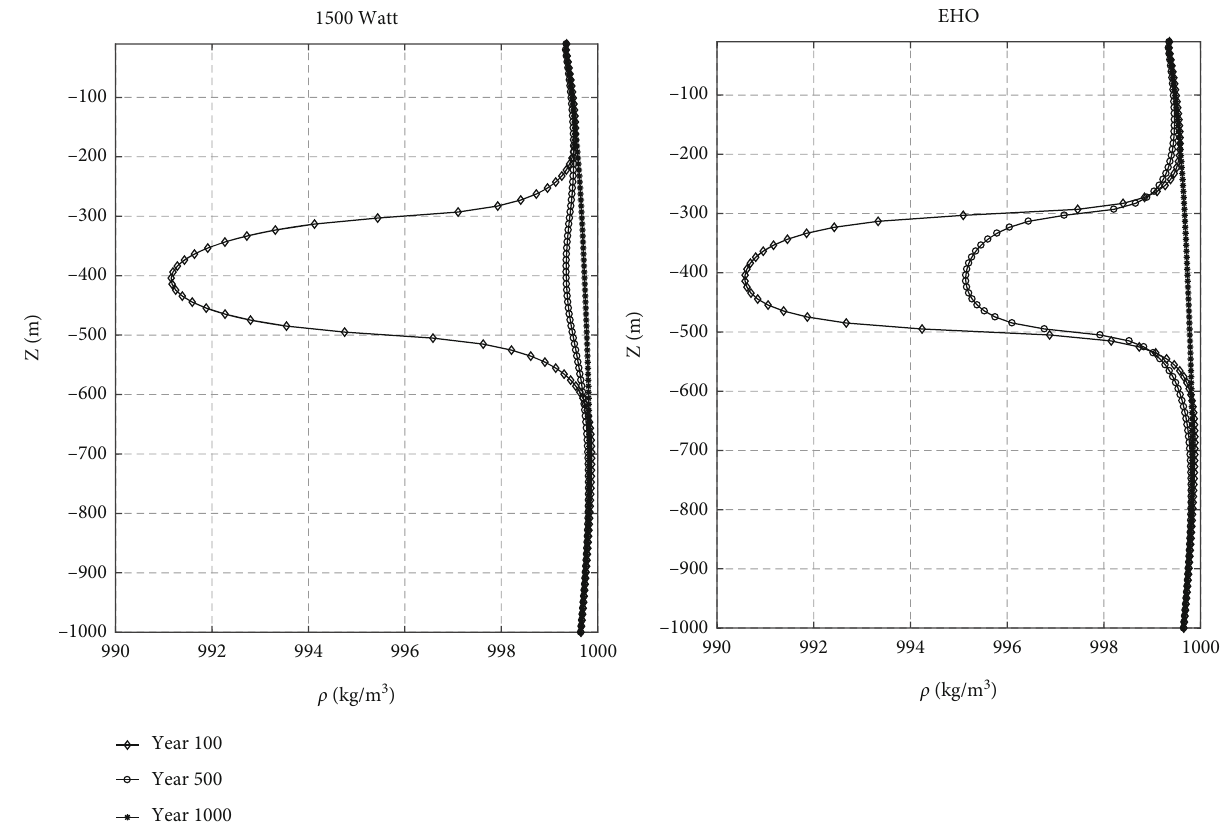
Figure 8: Temporal variation of the water density at radial distance R = 5 m for di ff erent heat outputs (1500W and extended heat output (EHO)) for a 0.5km deep disposal